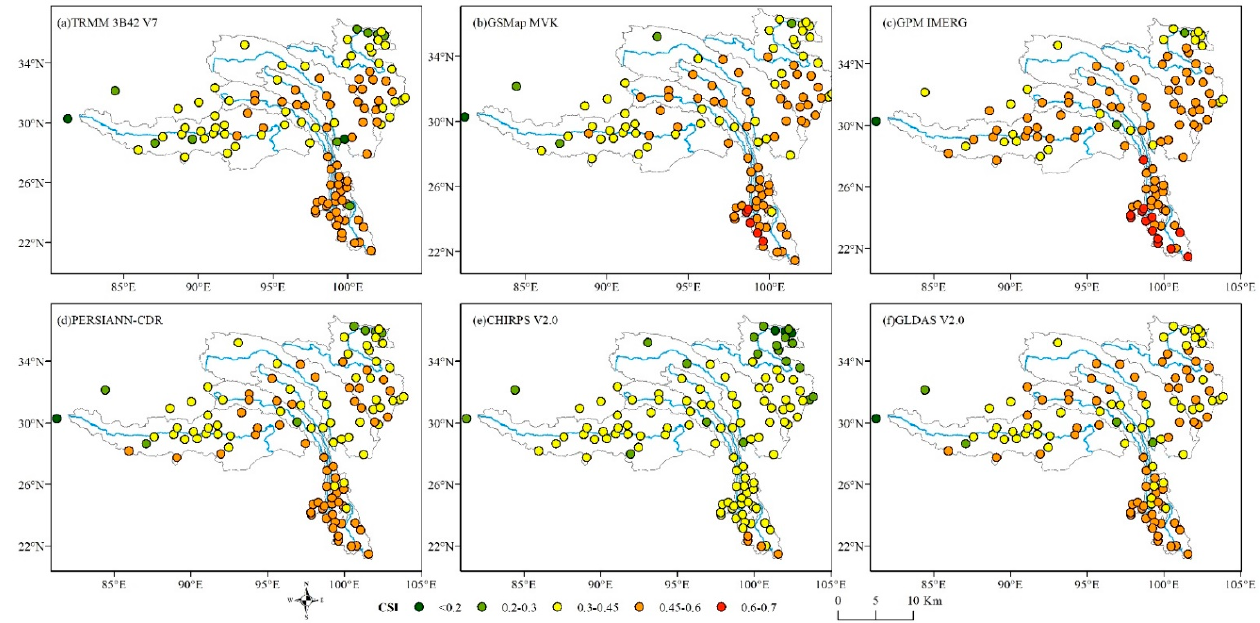
Figure 11. The CSI between different rain gauges and corresponding grids in data products.